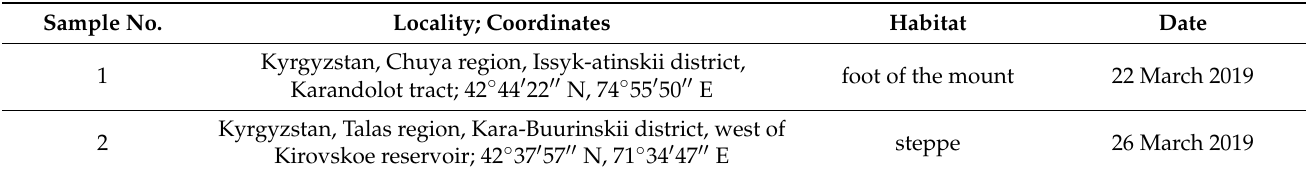
Table 3. Sites of collection of the analyzed